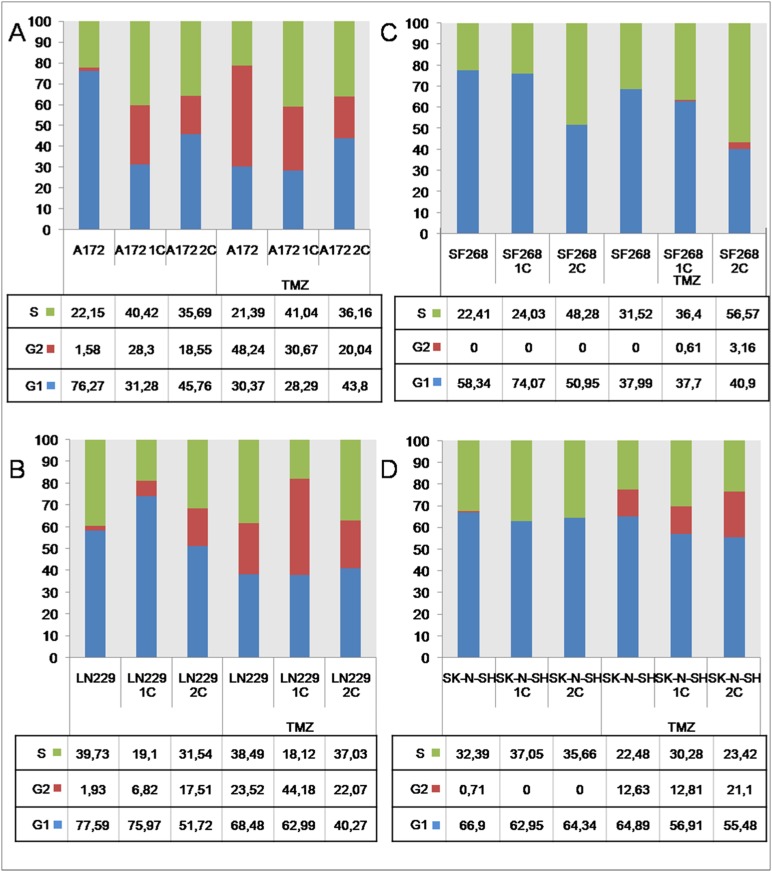
Cell cycle modulation induced by TMZ treatment.Modulation of the cell cycle (G1, S and G2) by TMZ treatment in A172 (A), LN229 (B), SF268 (C) and SK-N-SH (D) cell lines. The number of cells in the G1-, S or G2-phase is given as percentages of the total cell population.